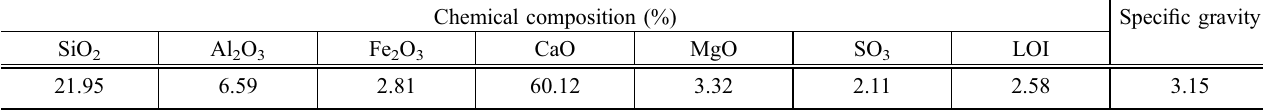
Table 4 Chemical composition of cement.